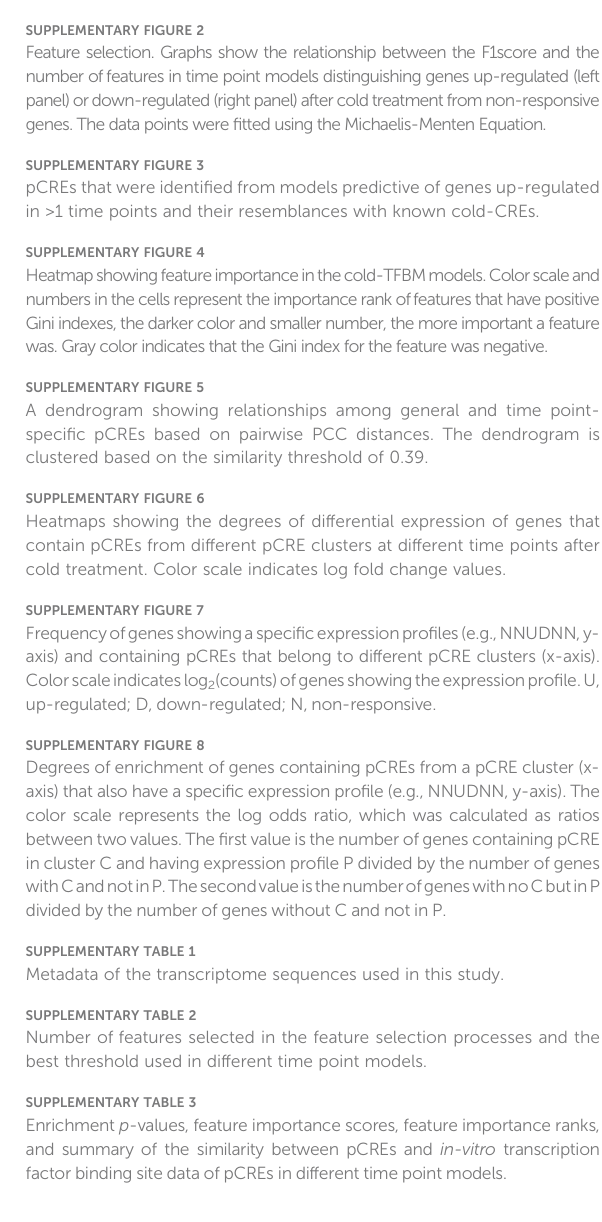
SUPPLEMENTARY FIGURE 1 Propertiesofcold-responsivegenesatdifferenttimepoints.( A)